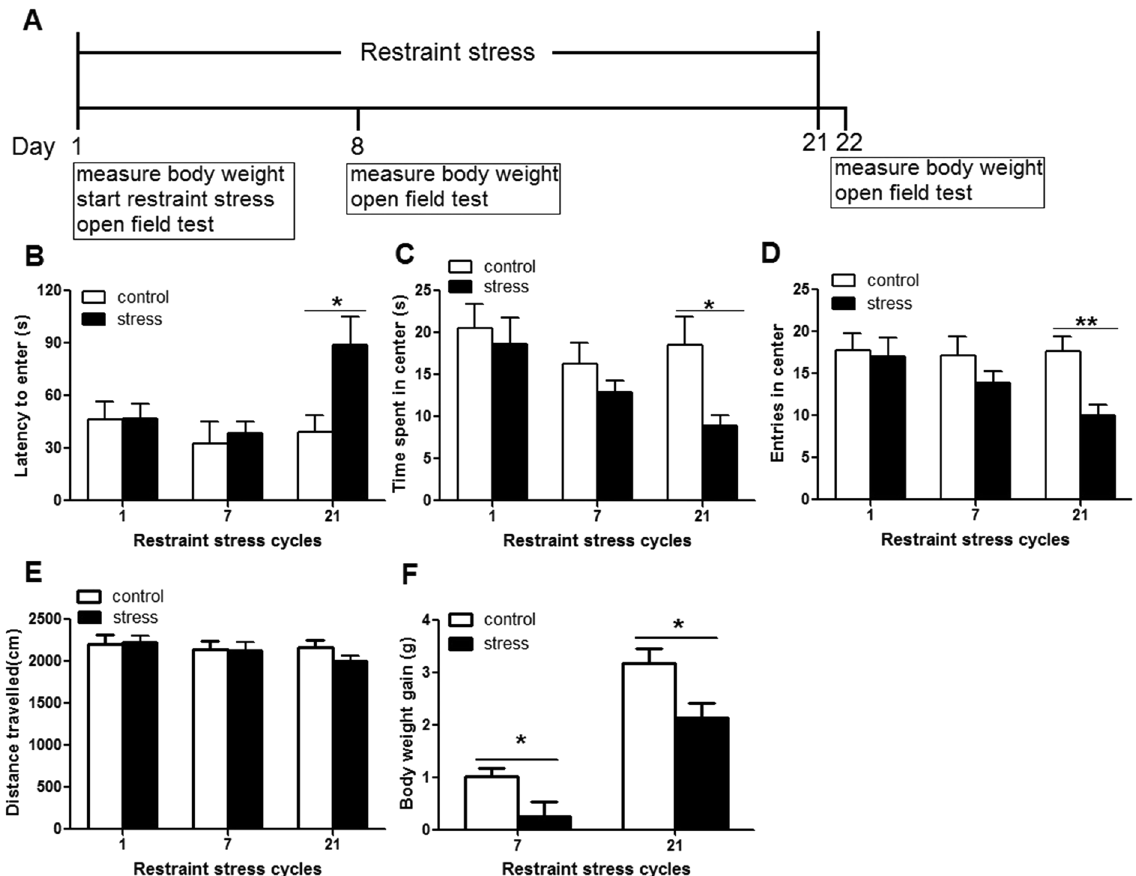
Figure 1. Restraint stress induced anxiety-like behavior in mice. Male C57BL/6 mice undergoing 1, 7 or 21 cycles of restraint stress (stress) or left undisturbed in home cage (control). ( A ) Experiment designs to test the impact of the restraint stress on mice. ( B , C and D ) Mice subjected to 21 cycles of restraint stress took longer to first enter the center of the open field ( B ), spent less time in the center of the open field ( C ), entered the center of the open field less often ( D ) than the controls. ( E ) There was no difference of the distance traveled in the open field between the restraint stressed mice and the control mice. ( F ) Body weight gain was reduced significantly after the mice undergoing 7 or 21 cycles of restraint stress. Data were shown as mean ± SEM (n = 10–15). * p < 0.05, ** p <